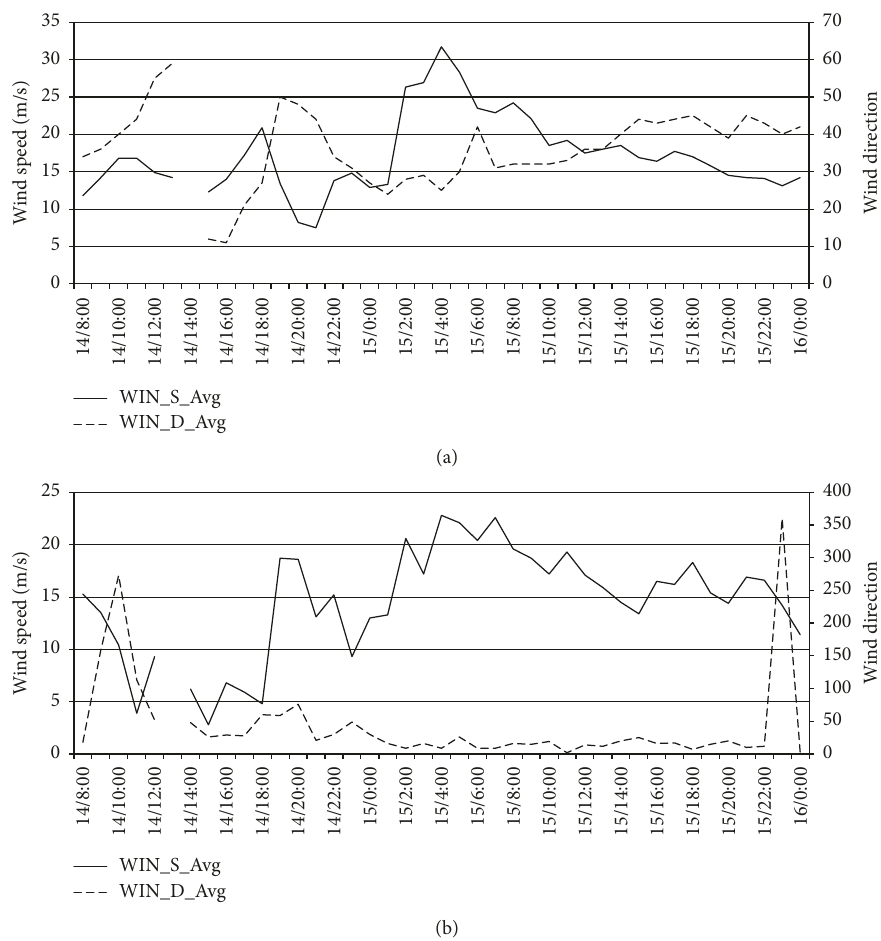
Figure 3: Wind change from 0800 UTC 14 August to 0000 UTC 16 August 2018. The hourly data were observed at (a) platform A and (b) platform